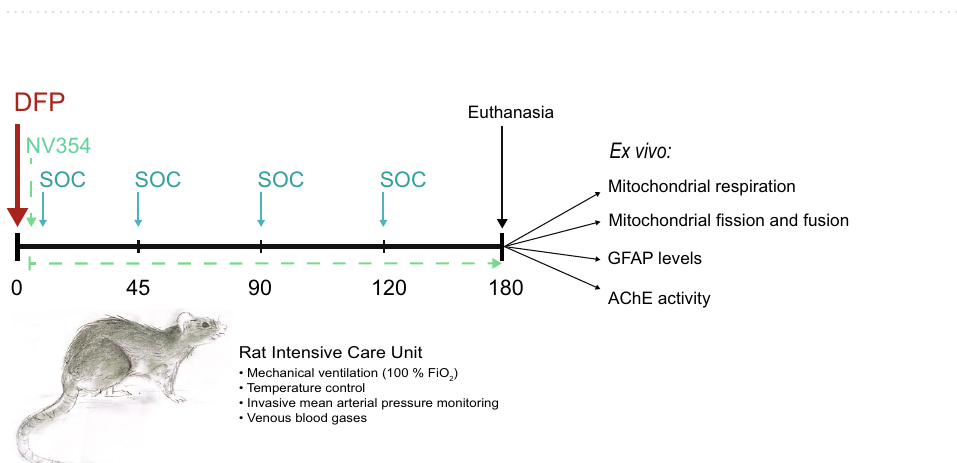
Table 1. Treatment groups and administered agents. DFP diisopropylfluorophosphate, SOC standard of care (atropine and pralidoxime), NV354 cell-permeable succinate prodrug.